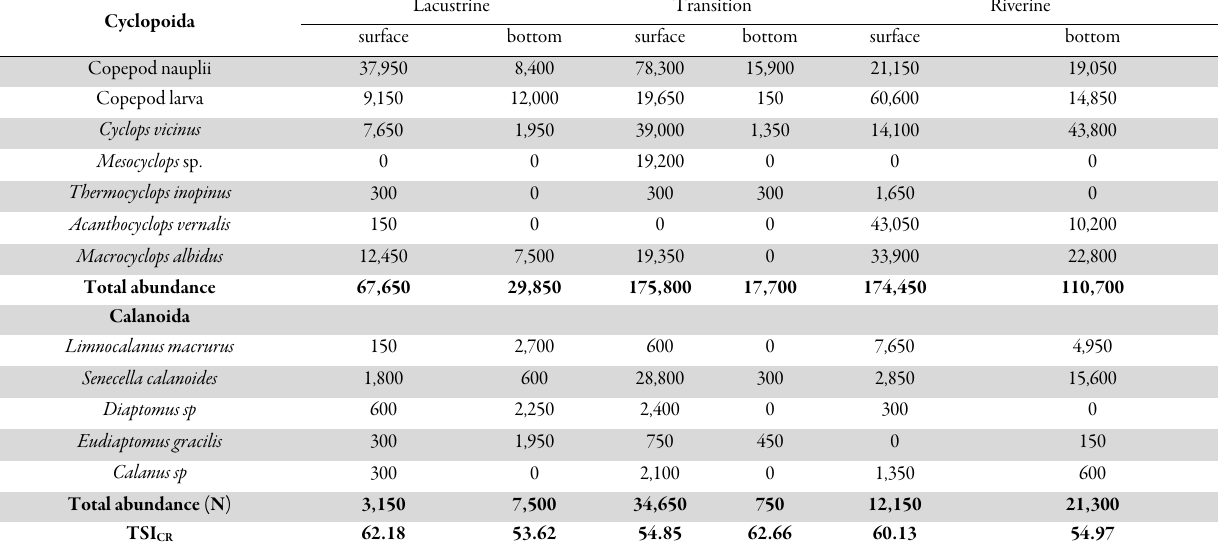
Table 9. Estimation of Trophic State Index using Cyclopoda and Calanoida